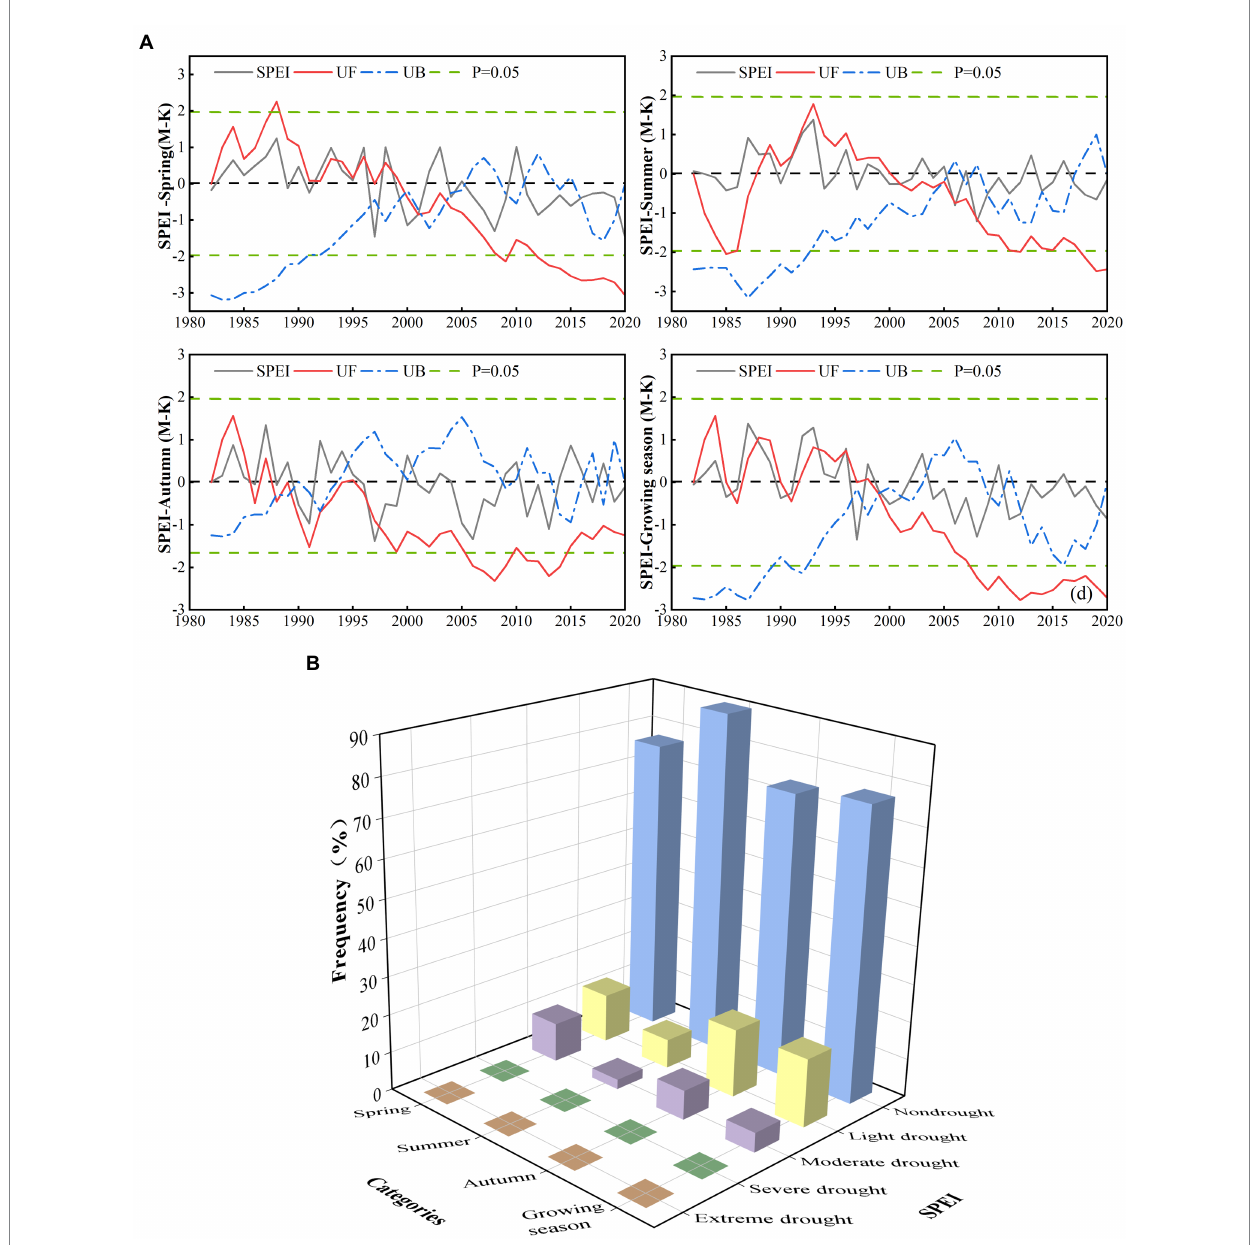
FIGURE 6 (A) Time series of the SPEI and Mann-Kendall test. (B) The frequency of different drought grades for the spring, summer, autumn, and growing season from 1982 to